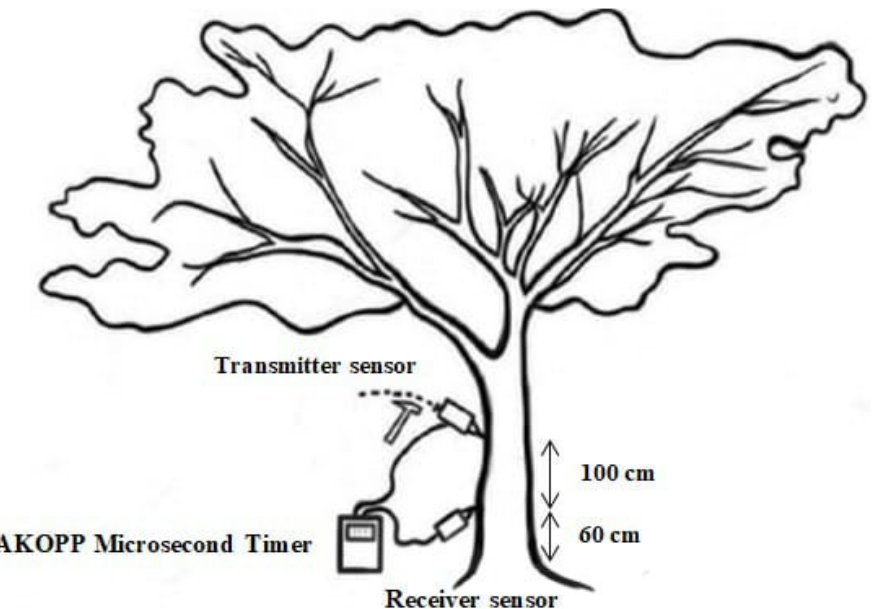
Figure 3. The sketch of the setup for stress wave velocity measurements.